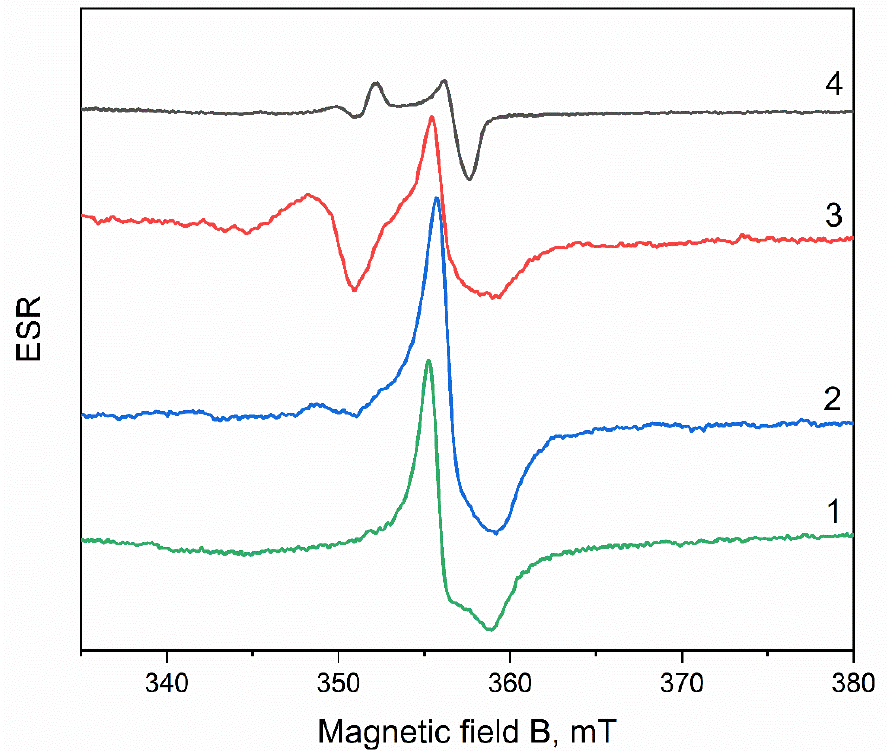
Figure 1. ESR spectra of unirradiated ZrO 2 (1) and irradiated with an electron beam with an energy of 130 keV (dose 15 kGy) (2), 10 MeV (fluence 10 15 electrons/cm 2 ) (3), and Xe ions with an energy of 220 MeV (fluence 10 13 ions/cm 2 ) (4).